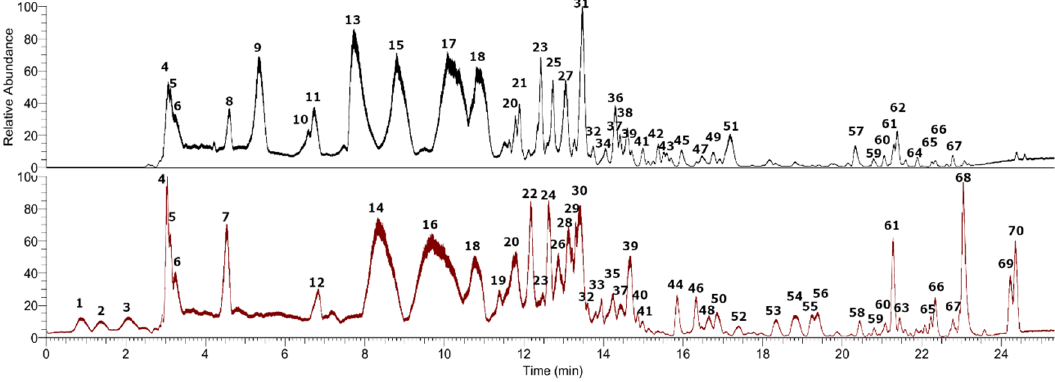
Figure 3. UHPLC chromatogram of Phycella cyrtanthoides bulbs (black) and leaves (red) in positive mode.